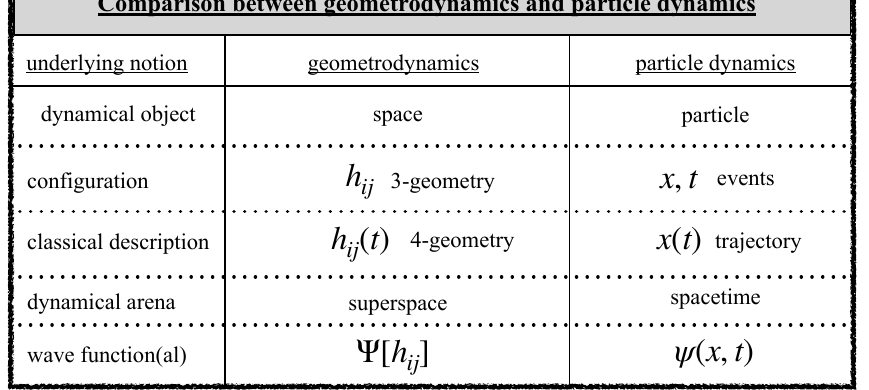
Figure 2. Geometrodynamics shares many properties with particle dynamics, and the relevant notions in both can be compared as shown. Modified and extended version of Box 43.1 in Ref.